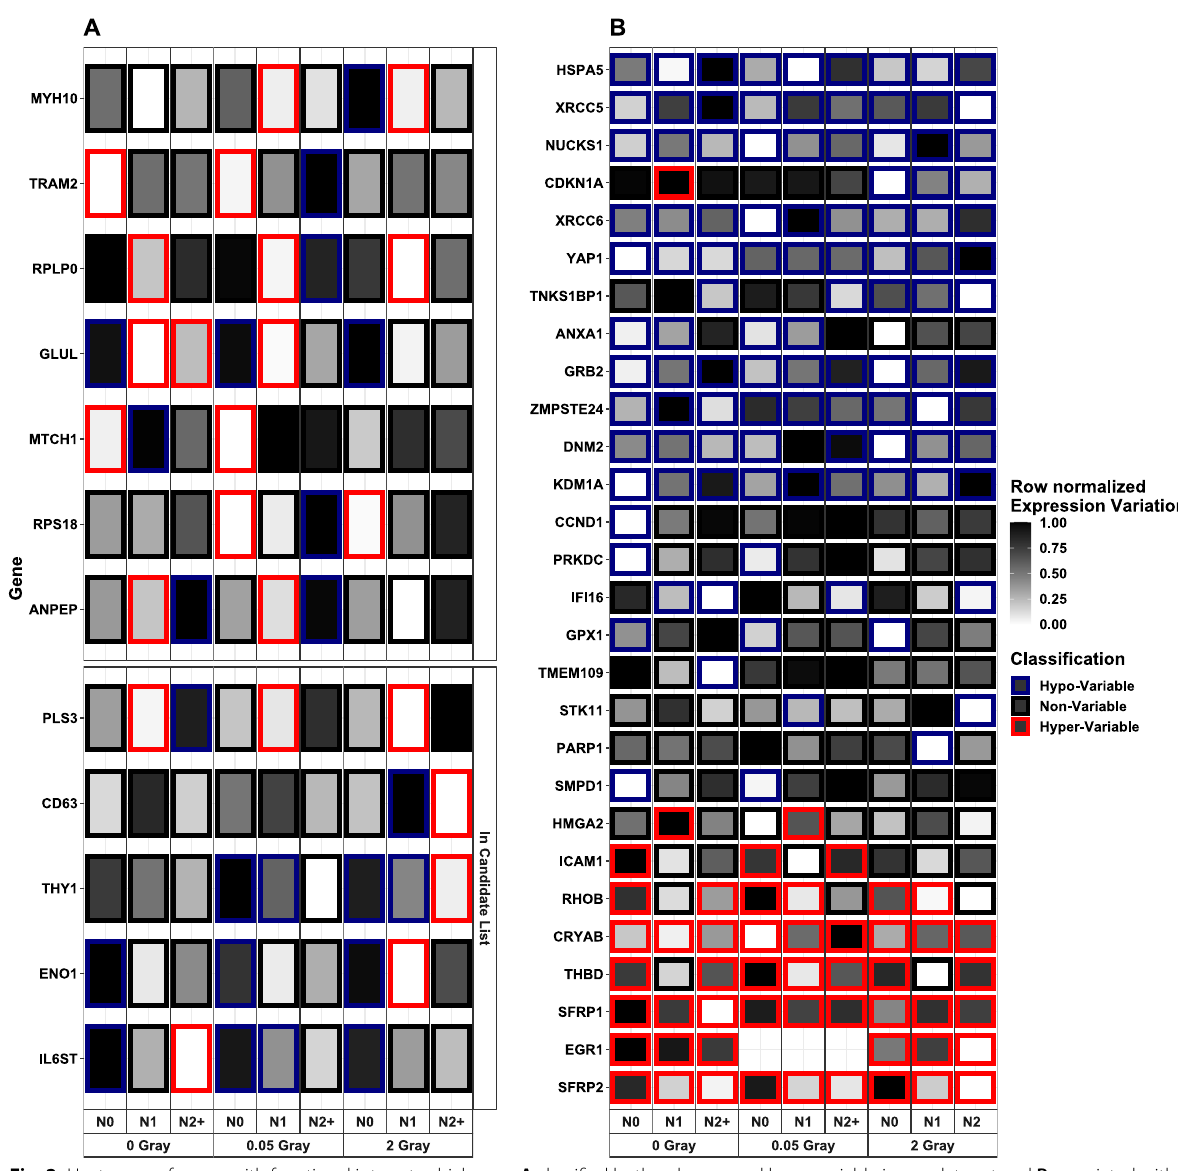
Fig. 2 Heat maps of genes with functional interest: which were A classified both as hyper‑ and hypo‑variable in any data set and B associated with the GO term response to radiation and ‑showed a classification range from to hyper‑variable across all donor groups. Genes in A were additionally filtered for genes found in the RadAtlas database for radiation‑associated genes, genes associated with DNA repair functions, or that were annotated to the Gene Ontology (GO) terms response to stress or response to radiation (see facet Candidate List). N0 controls, N1 fibroblasts of childhood cancer survivors without a second primary neoplasm, and N2 = with at least one second primary